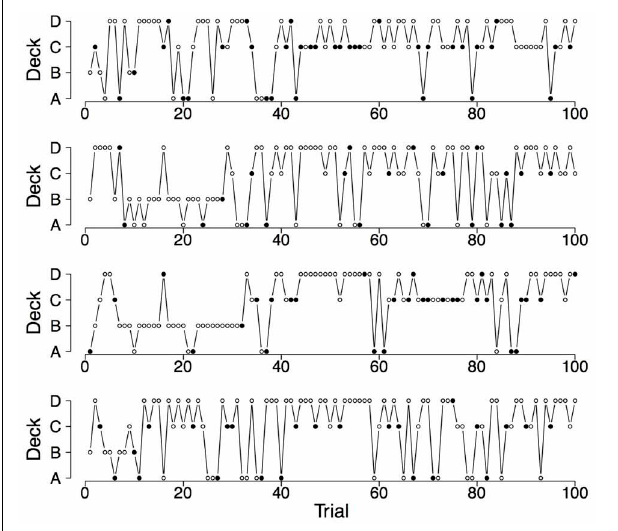
FIGURE 3 | Deck selection profiles of four synthetic participants showing a pronounced preference for the good decks (generated by the PVL-Delta model; A = 0 . 88 , w = 0 . 68 , a = 0 . 25 , c = 1 .